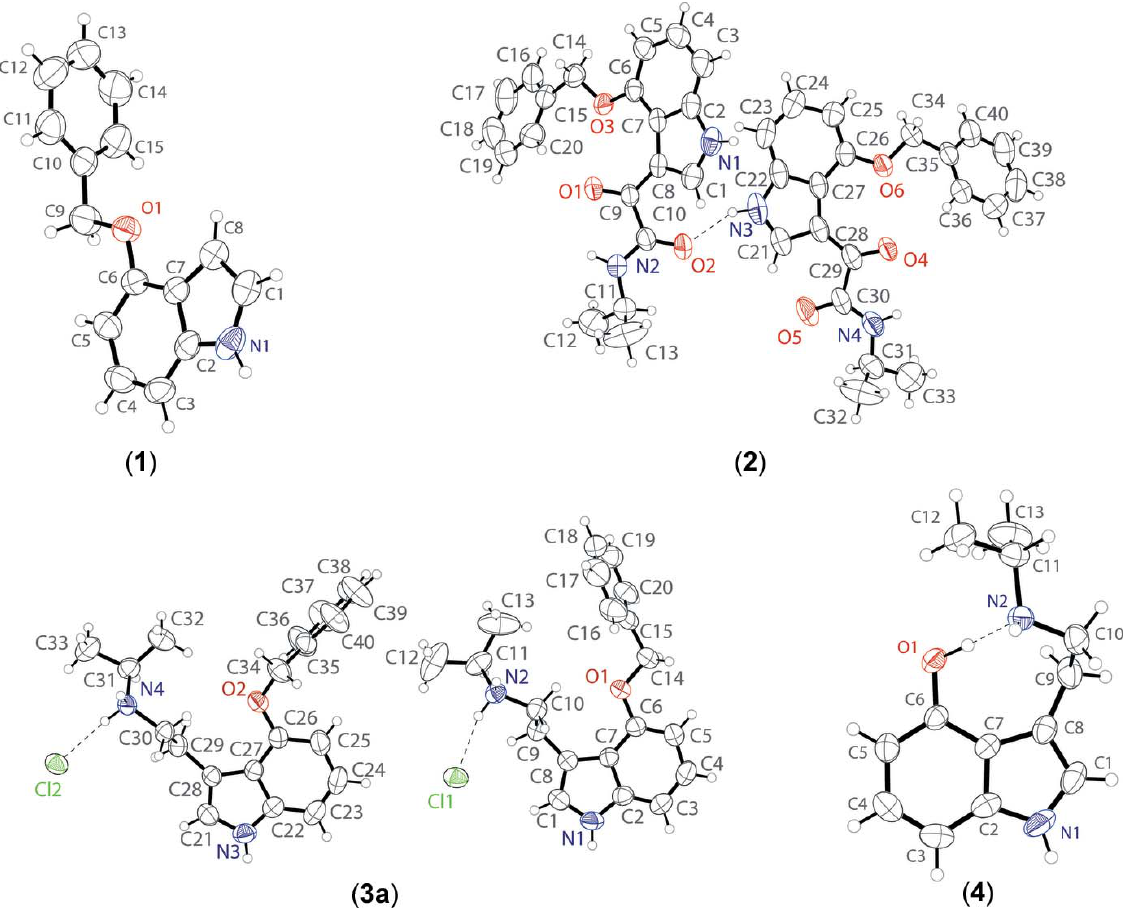
Figure 1 The molecular structures of 4-benzyloxyindole ( 1 ) (top left), N -2-propyl- (cid:2) -oxo-4-(phenylmethoxy)-1 H -indole-3-acetamide ( 2 ) (top right), 4-benzyloxy- N -isopropylammonium chloride ( 3a ) (bottom left), and 4-hydroxy- N -isopropyltryptamine ( 4 ) (bottom right), showing the atomic labeling. Displacement ellipsoids are drawn at the 50% probability level. Hydrogen bonds are shown as dashed